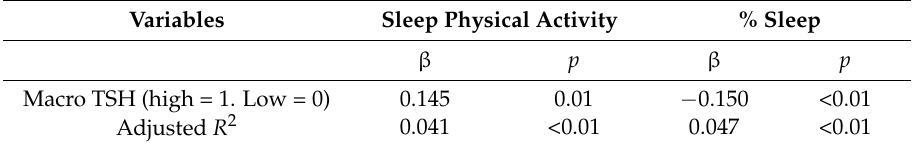
Table 3. Multiple linear regression analyses of macro TSH and sleep parameters.